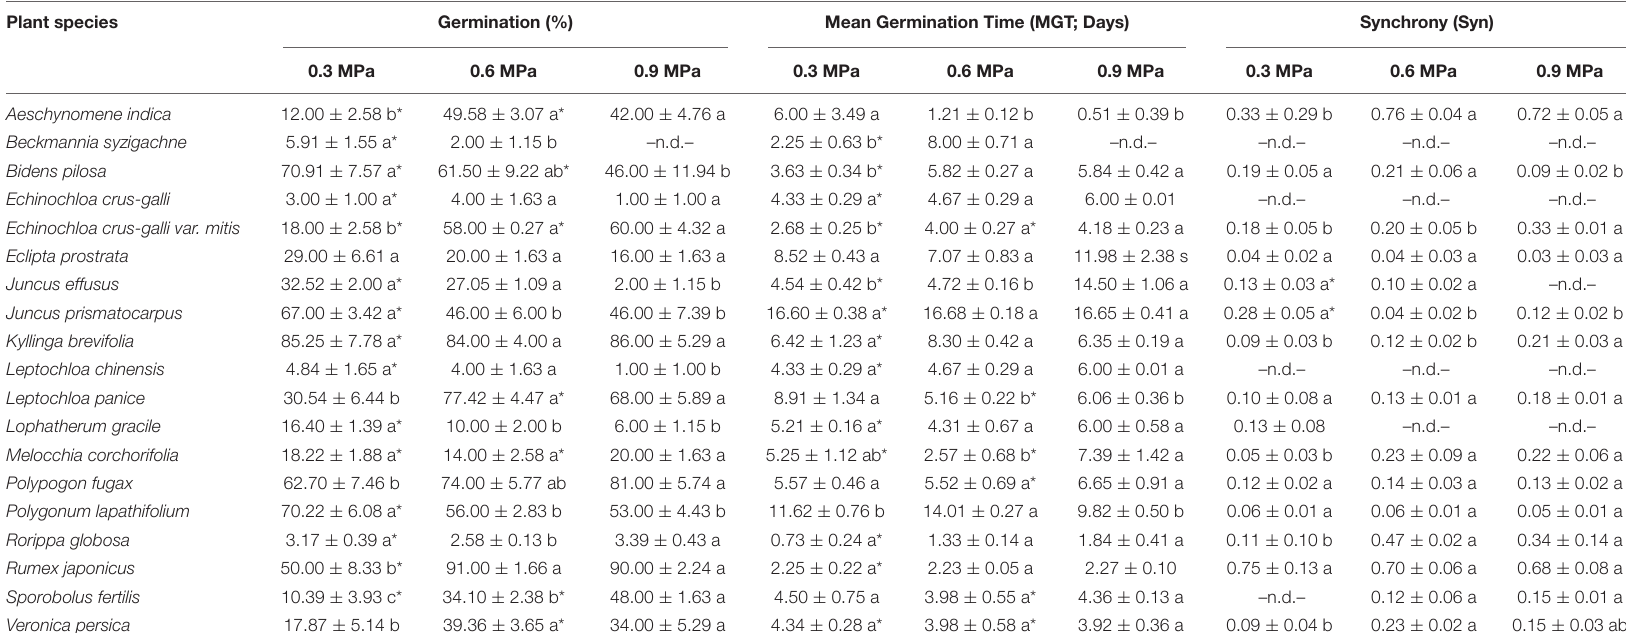
Each value denotes mean ( ± SE). Within features, different lowercase letters denote significance at P ≤ 0.05. Values marked with asterisks (*) are statistically different from those measured durisng water